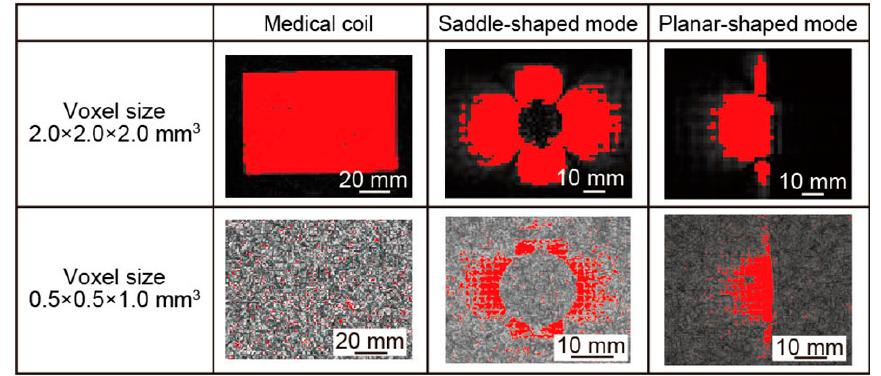
Figure 10. The visible area of the MRI images of medical head coil, saddle-shaped coil, and planar-shaped mode coils with the voxel size of 0.5 × 0.5 × 1.0 mm 3 and 2.0 × 2.0 × 2.0 mm 3 . Red pixels show the visible area of the coil. Table 3. The size of the visible area of the medical and micro saddle coil.